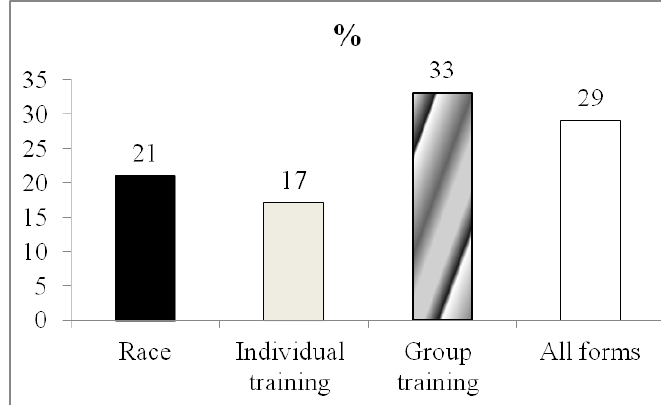
Figure 4. The percentage of injuries in relation to training